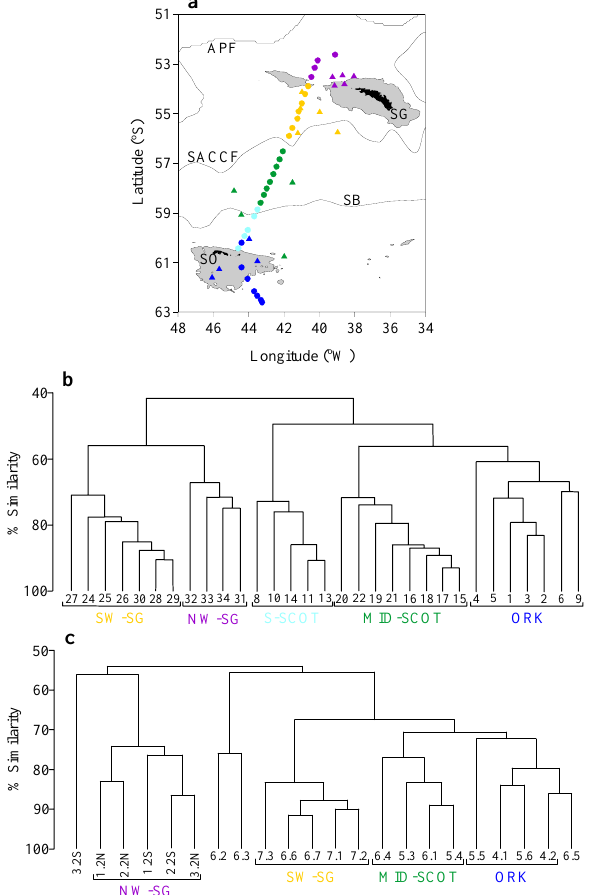
Fig. 2. (a) Location of the 2008 (circles) and 2003 (triangles) re- gional station groups from cluster analysis. (b) Cluster diagram of phytoplankton abundance for 2008 and (c) 2003. Black bars indi- cate distinct station groups at the 60% (b) and 72% (c) Bray-Curtis similarity level. Station groups from south to north are: ORK – South Orkney, S-SCOT – southern Scotia Sea, MID-SCOT – cen- northwest of South Georgia.